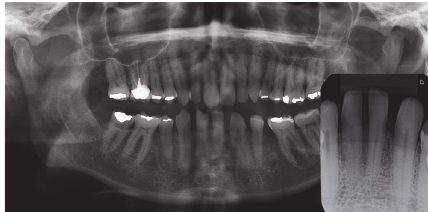
Figure 2: Panoramal radiograph showing agenesis of the lower lateral incisors and premolars. Inset periapical radiograph showing no evidence of bone involvement.